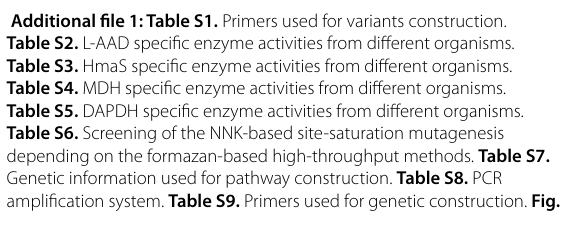
Table S3. HmaS specific enzyme activities from different organisms. Table S4. MDH specific enzyme activities from different organisms. Table S5. DAPDH specific enzyme activities from different organisms. Table S6. Screening of the NNK-based site-saturation mutagenesis depending on the formazan-based high-throughput methods. Table S7. Genetic information used for pathway construction. Table S8. PCR amplification system. Table S9. Primers used for genetic construction. Fig.